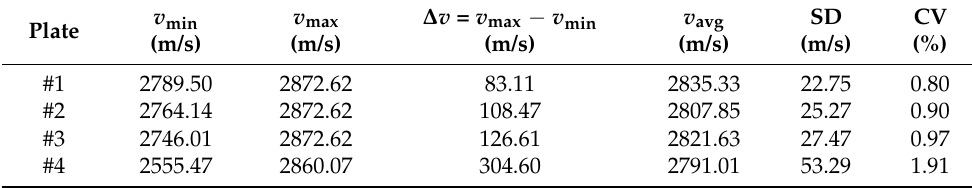
Table 1. Wave propagation velocities in steel plates for data from experimental